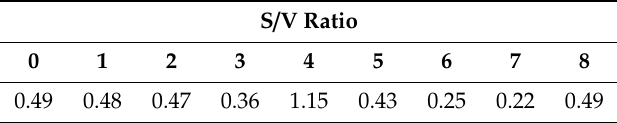
Table 7. Surface / volume ratios of the nine stockpiles (in C